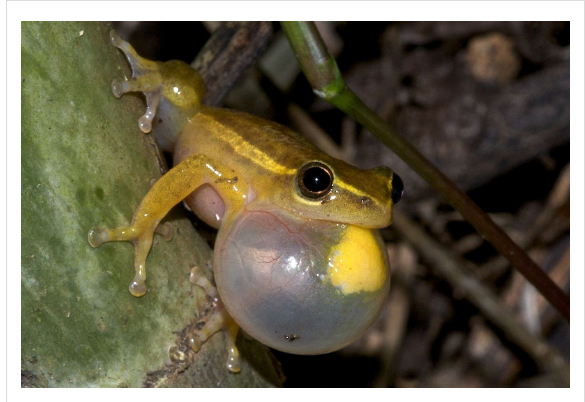
Figure 1: Calling male Hyperolius cinnamomeoventris with exposed vocal sac carrying the yellow gular gland. Figure 1 was reprinted from [2], I. Starnberger et al., “Take time to smell the frogs: vocal sac glands of reed frogs (Anura: Hyperoliidae) contain species-specific chemical